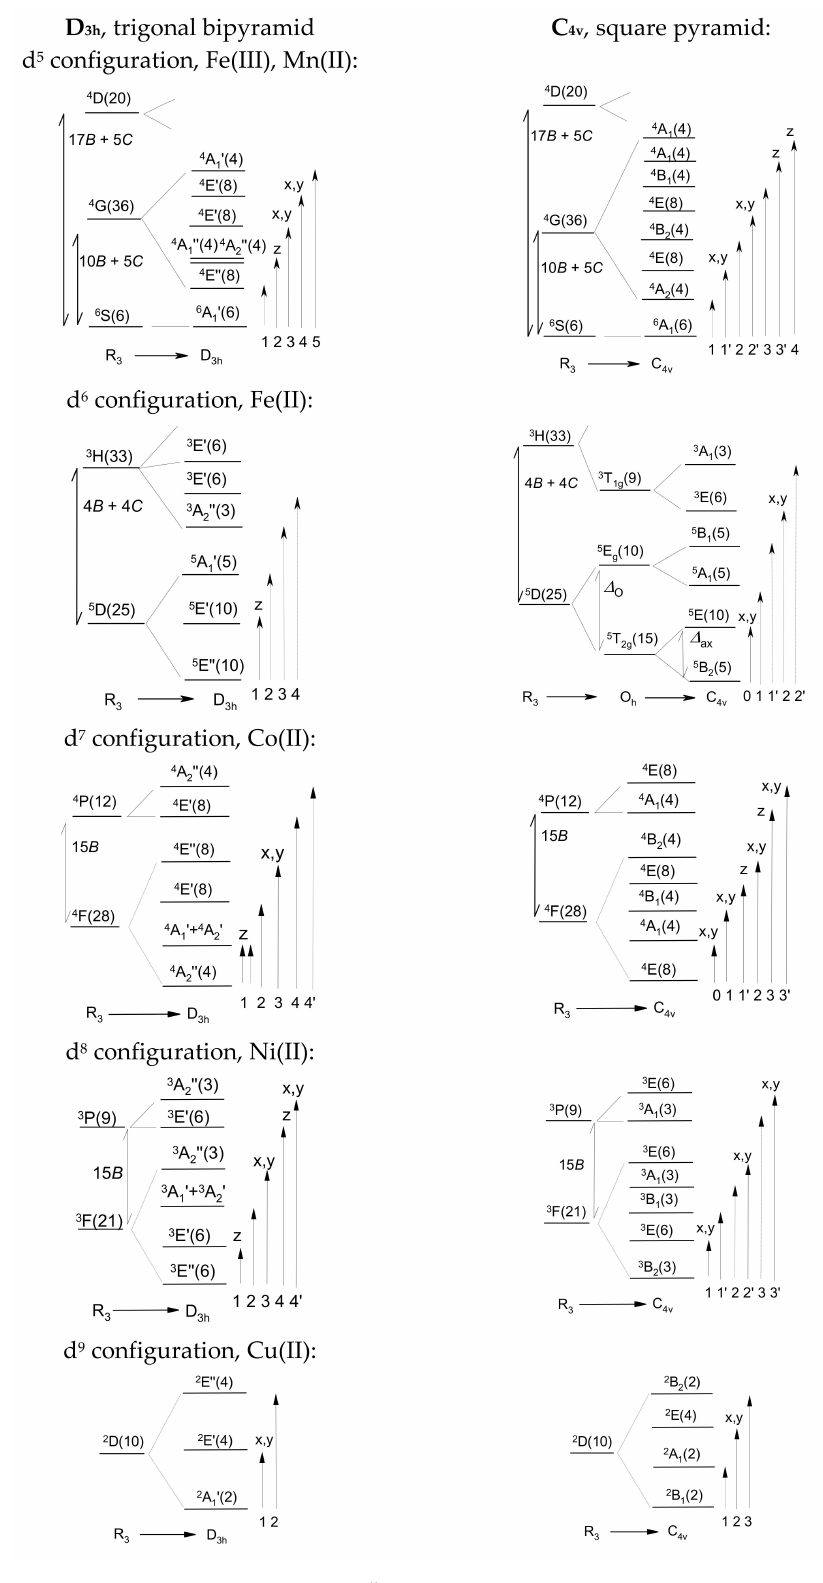
Figure 1. Crystal field terms for d n configurations (energies not to scale). The electronic terms are labelled by exploiting the IRs of the point group, with the spin multiplicity as the superscript index and degeneracy in parentheses, e.g., 4 G(36). Dipole transitions: forbidden—dashed arrows, allowed—solid